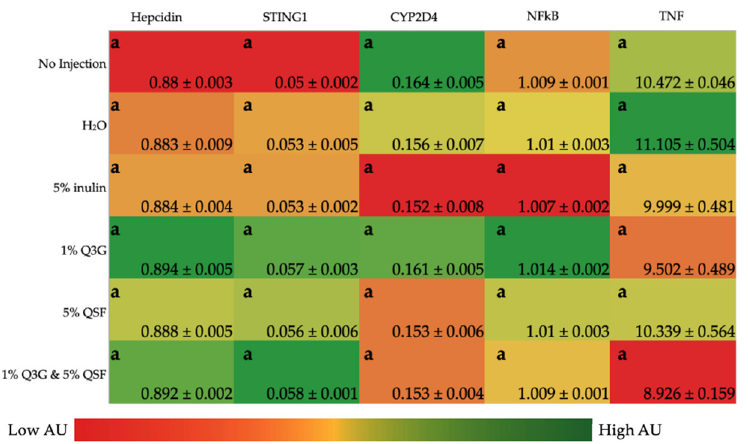
Figure 2. Effect of the intra-amniotic administration of treatments and controls on liver gene expression. Values are the means (AU: arbitrary units) ± SEM, n = 6. Values (column wise) are not statistically significant ( p < 0.05). STING1, stimulator of interferon genes; Cyp2d4, cytochrome P450, family 2, subfamily d, polypeptide 4; NF- κβ , nuclear factor kappa beta; TNF- α , tumor necrosis factor. Q3G, quercetin 3-glucoside; QSF, quinoa soluble fiber.